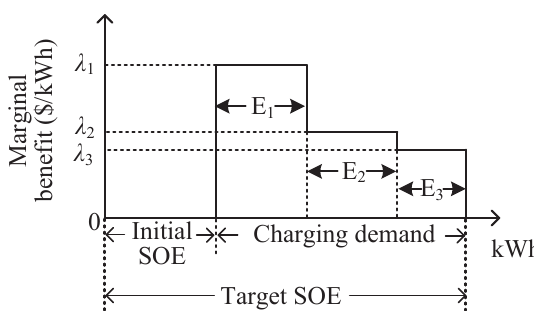
Figure 4. Demand curves of plug-in electric vehicle